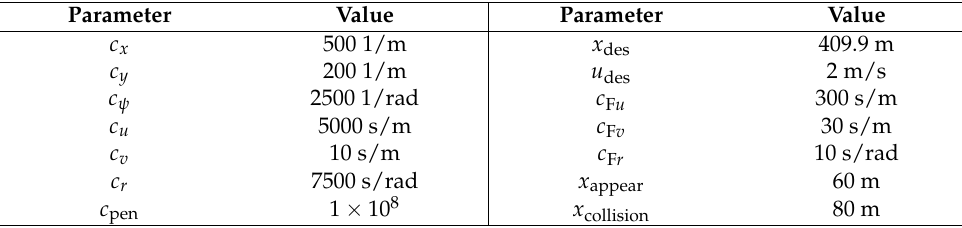
Table 5. Coefficients of the costs (33) and the feature costs